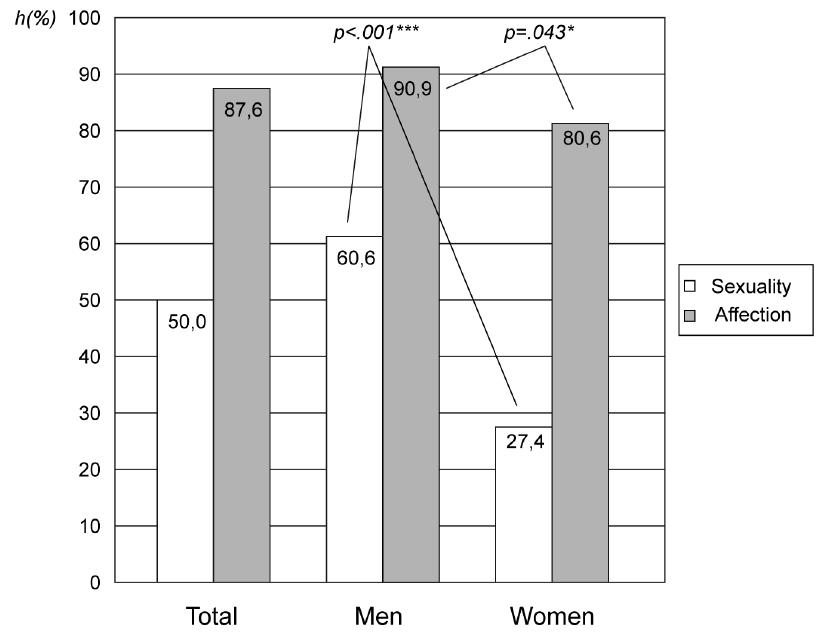
Figure 3. Percentage of elderly in the group MP 74 years to whom sexuality and affection is important. Summary of the relative frequencies ‘level 4’ (quite important) and ‘level 5‘ (very important). Results of Pearson’s Chi-Squared-Test. ***p , .001.